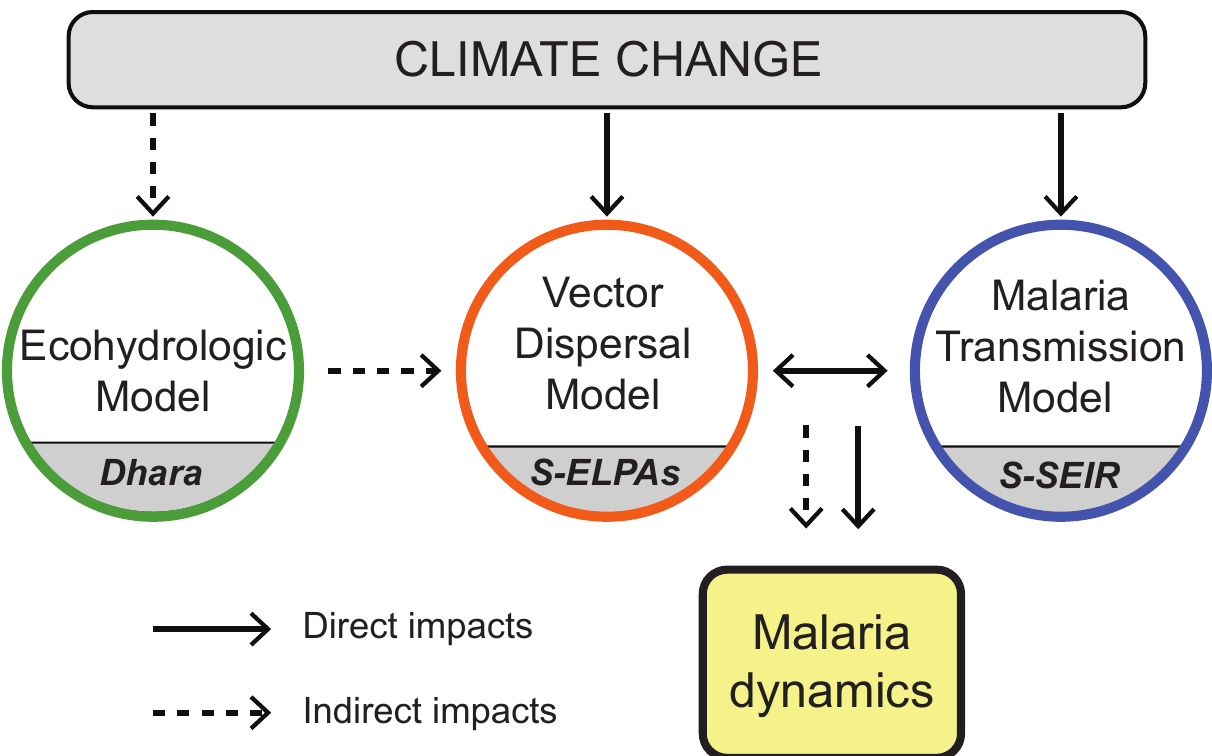
Fig 1. Schematic of SLIM model for predicting malaria dynamics under climate change. SLIM consists of two time-continuous space-discrete models (S-ELPAs and S-SEIR) that considered the nonlinear relationship between temperature and Plasmodium development inside Anopheles vectors for estimating the EIP. SLIM is linked with an ecohydrologic modeling framework ( Dhara ) to incorporate the acclimatory responses of vegetation on soil moisture and breeding habitat of vectors under climate change. Solid arrows represent direct impacts of temperature increase on malaria. Dash arrows represent the indirect impacts of ecohydrologic acclimation under climate change on